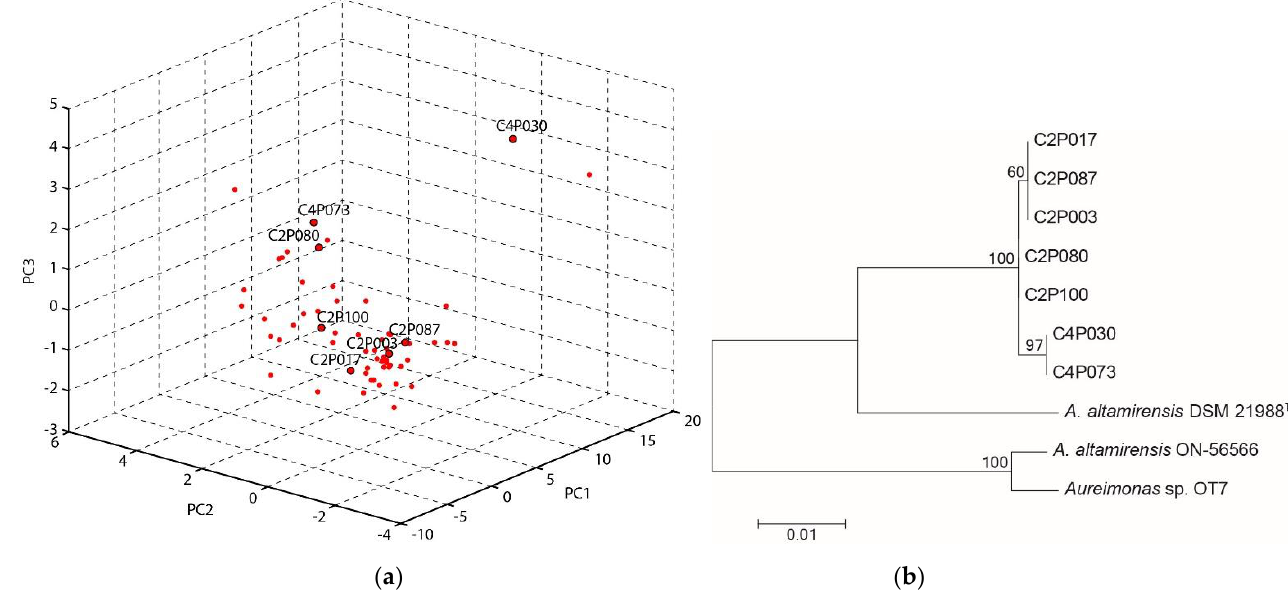
Figure 1. Variability of the A. altamirensis isolates obtained from ash trees: ( a ) Ordination plot of MALDI-TOF MS spectra, calculated by a principal component analysis. ( b ) Maximum-likelihood tree of the IGS gene sequences of selected ash-associated A. altamirensis isolates and two clinically derived strains (ON-56566, OT7) as well as the type strain DSM 21988. Numbers at branch nodes refer to bootstrap values >50%.